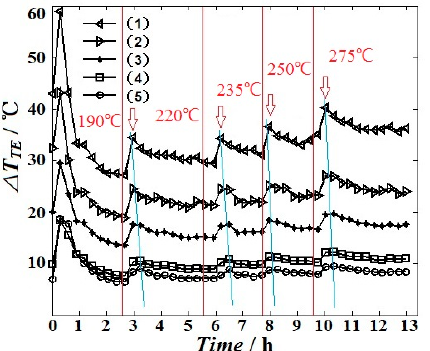
Figure 6. Variation in temperature difference of thermoelectric modules with time.